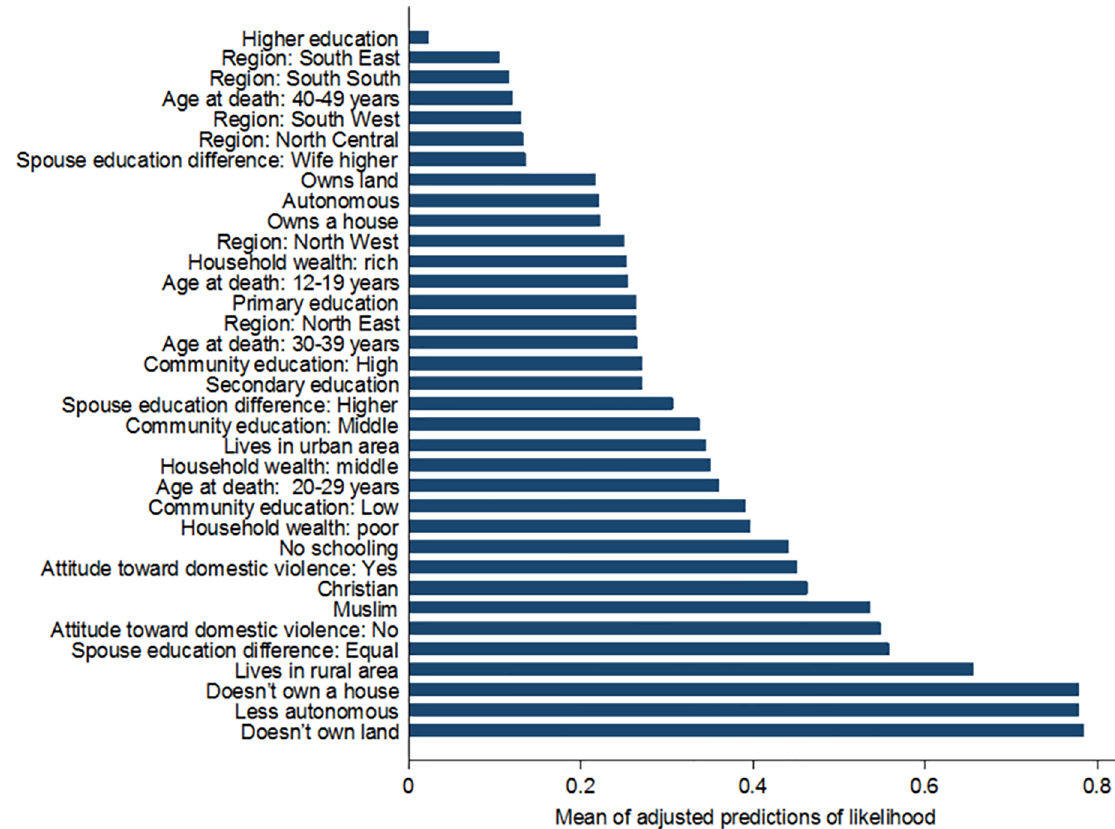
Fig 1. Adjusted predictions of the likelihood (odds ratios) of pregnancy-relatedmortality at the means of the independent variables, Nigeria Demographic and Health Survey